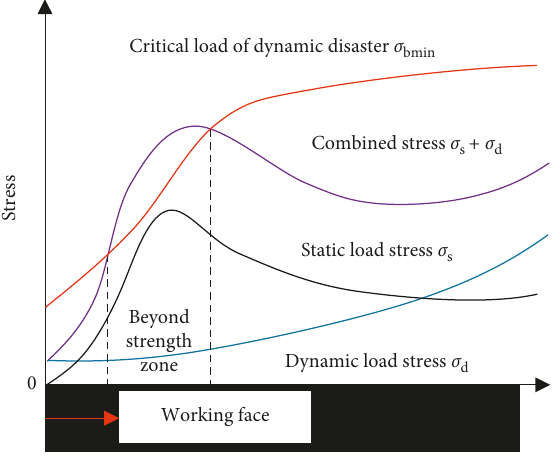
Figure 1: Superposition of loads near coal working